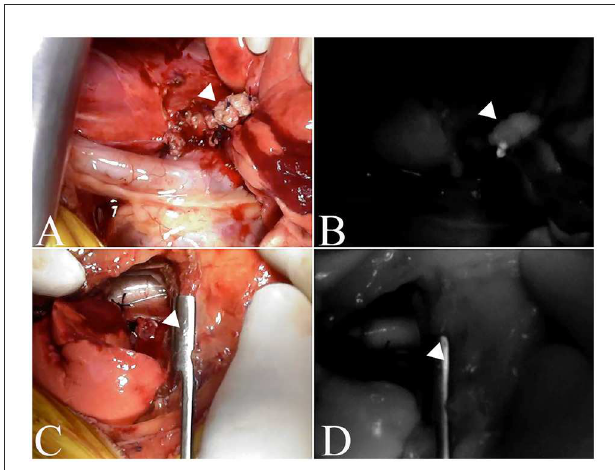
between CT findings and histopathological metastasis of the lymph nodes ( p =